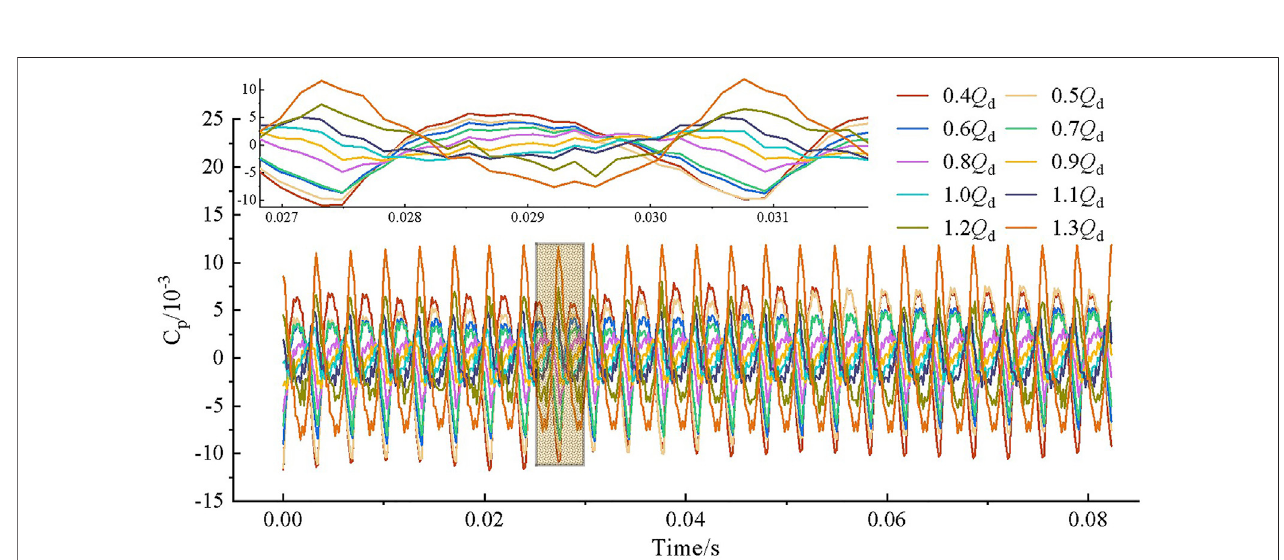
FIGURE 9 | Time domain diagram of pressure pulsation under dimensionless partial conditions.